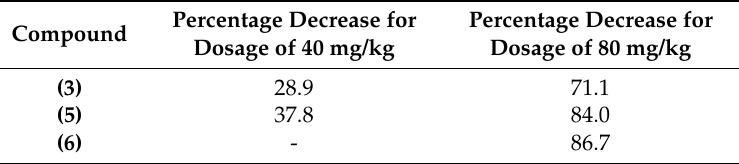
Table 2. Percentage decrease in Immobility